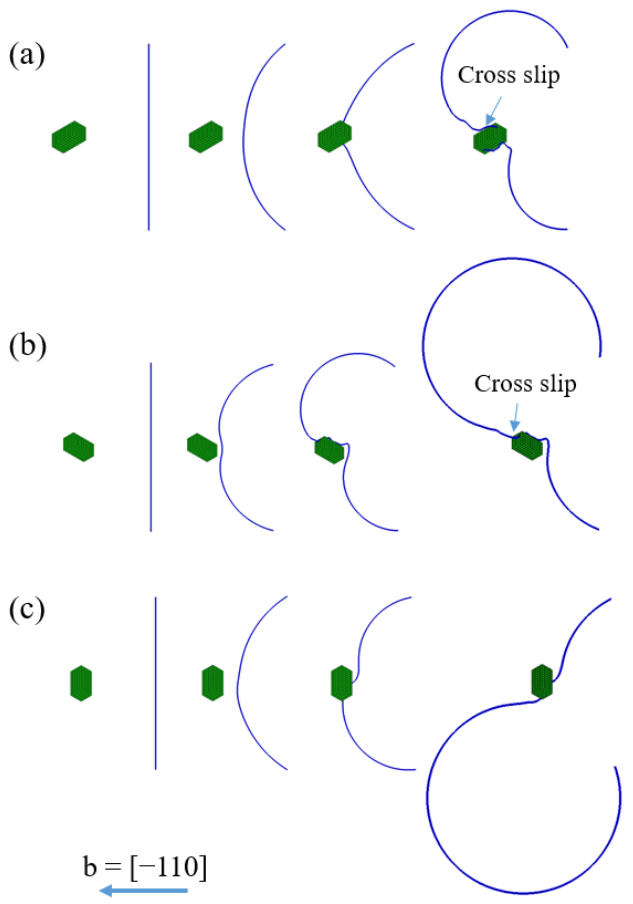
Figure 6. An edge dislocation bypassing a rod precipitate with orientation of ( a ) [100], ( b ) [010], ( c ) [001]. Dislocation lies in the slip plane at z = 0.